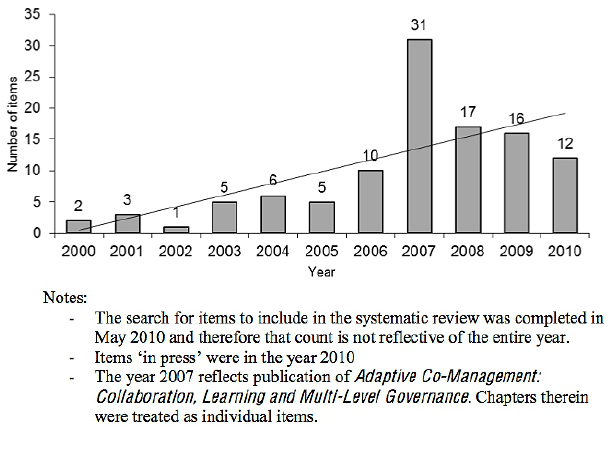
Fig. 2. Adaptive comanagement items in the